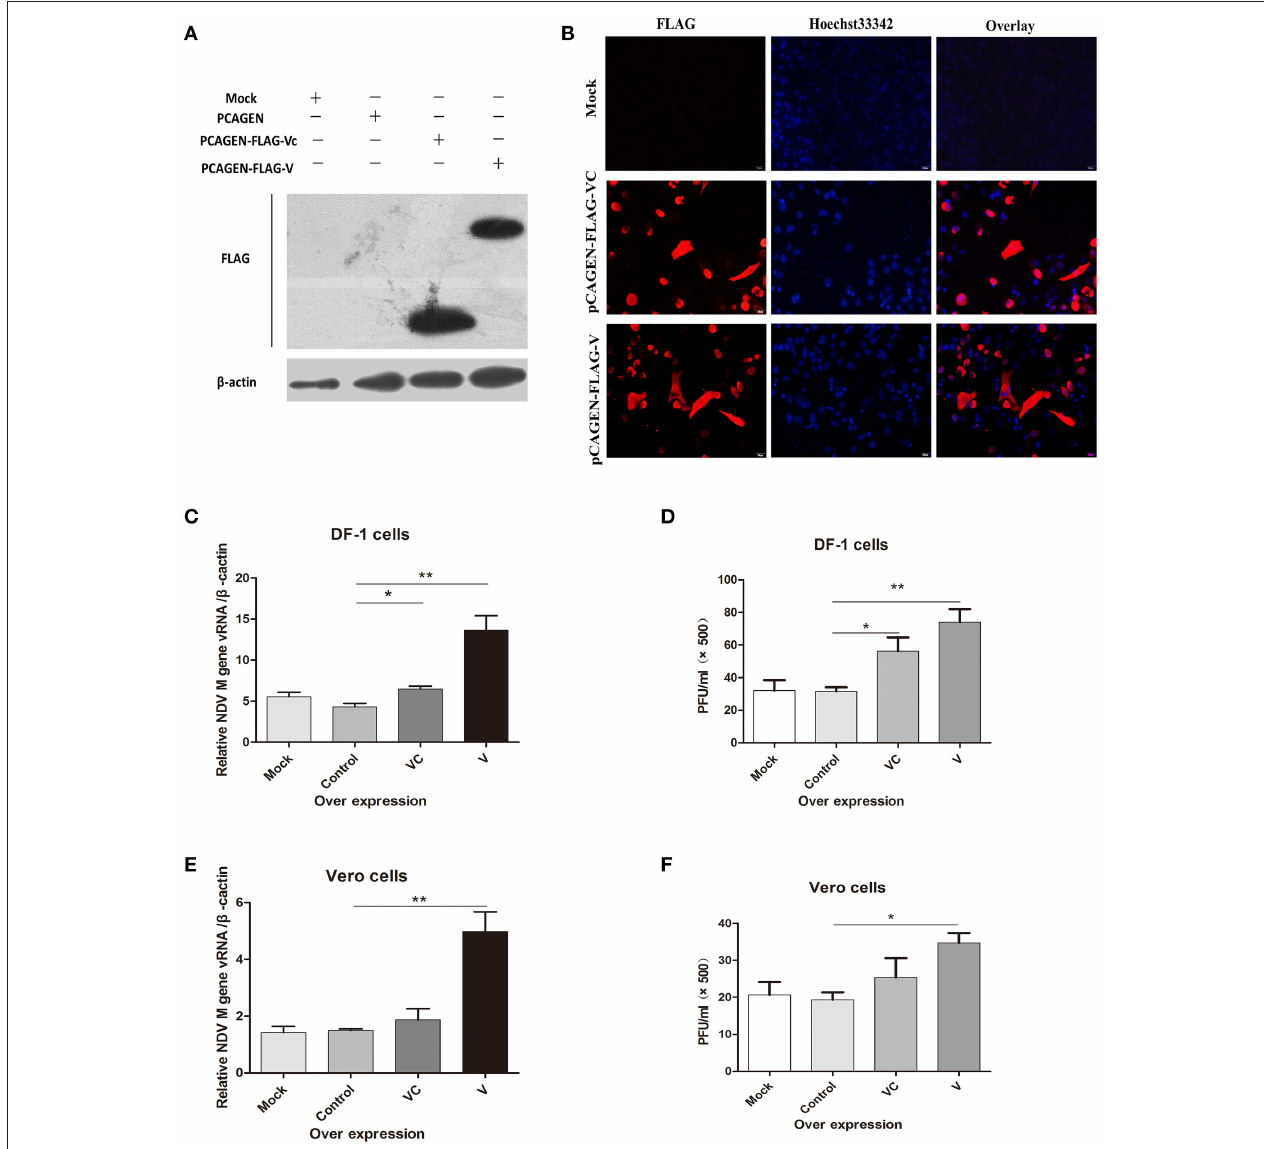
FIGURE 1 | Overexpression of the F48E9V protein promoted NDV replication in DF-1 and Vero cells. Forty-eight hours after transfection of DF-1 and Vero cells with mock (treated with transfection reagent), control (transfected with pCAGEN), VC (transfected with pCAGEN-Flag-VC), and V (transfected with pCAGEN-Flag-V), (A) western blotting and (B) immunofluorescence were performed to detect the protein expression of V and VC in DF-1 cells. (C) Q-PCR was performed to test the total viral RNA 24h after V protein overexpression in DF-1 cells. The cells were infected with F48E9 (1 MOI) for an additional 24h, and (D) a viral plaque assay was carried out to test the viral titer in the supernatant of the DF-1 cells(and date from from all four independent experiments, by the geometrical mean of the technical triplicate). (E) Q-PCR was performed to test the total viral RNA 24h after V protein overexpression in Vero cells. The cells were infected with F48E9 (1 MOI) for an additional 24h, and (F) a virus plaque assay was carried out to test the viral titer in the supernatant of the Vero cells. Data are the mean ± SD of triplicate samples from a single experiment and are representative of four independent experiments. * P < 0.05 and ** P <